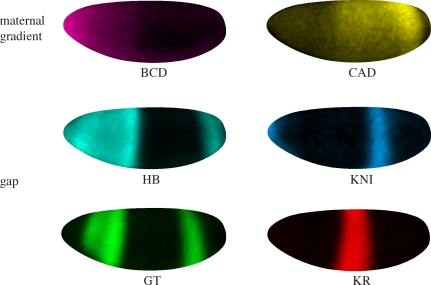
Patterns of mRNA Expression of the Six Maternal and Gap Genes Controlling Trunk Segmentation along the Anterior–Posterior AxisExpression (protein for BCD and mRNA for the other factors) is shown in orthographic projections using PointCloudXplore [100] to display data from the BDTNP's VirtualEmbryo [11] (BDTNP, unpublished data). The embryos are shown with anterior to the left, posterior right, dorsal at the top, and ventral at the bottom.